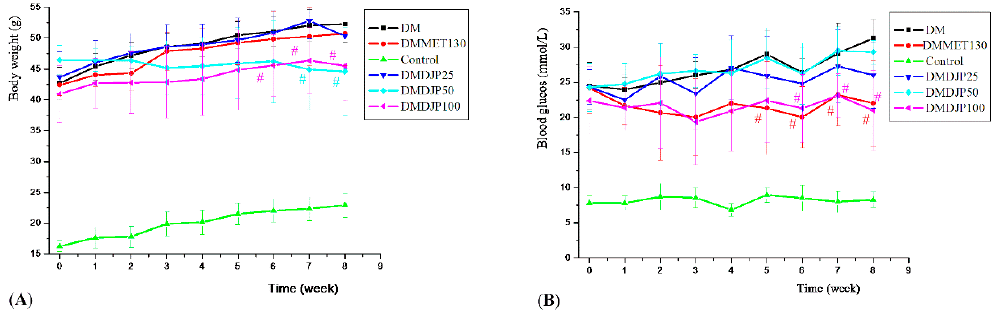
Figure 1. Effects of D. loddigesii (DJP) on body weight and blood glucose level across time in the mice. ( A ) Body weight changes over time; ( B ) Blood glucose level changes over time. Data are mean ± SD; # = p < 0.05 vs. DM group.